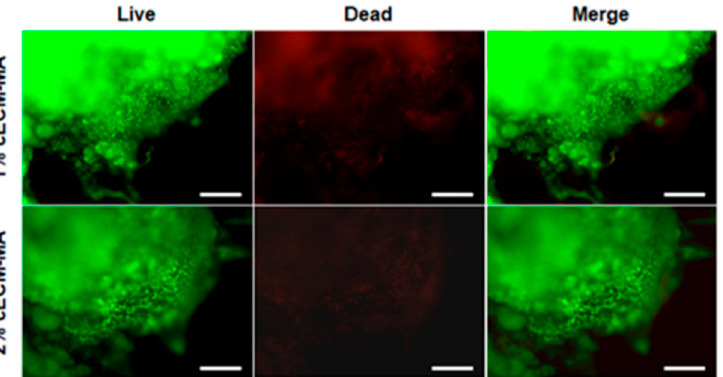
Figure 6. Cell viability 7 days following encapsulation in cECM-MA. Living cells are stained in green, and dead cells are stained in red (scale bars = 200 µm). Adapted under open access Creative Commons CCBY 4.0 license from Ref [56].